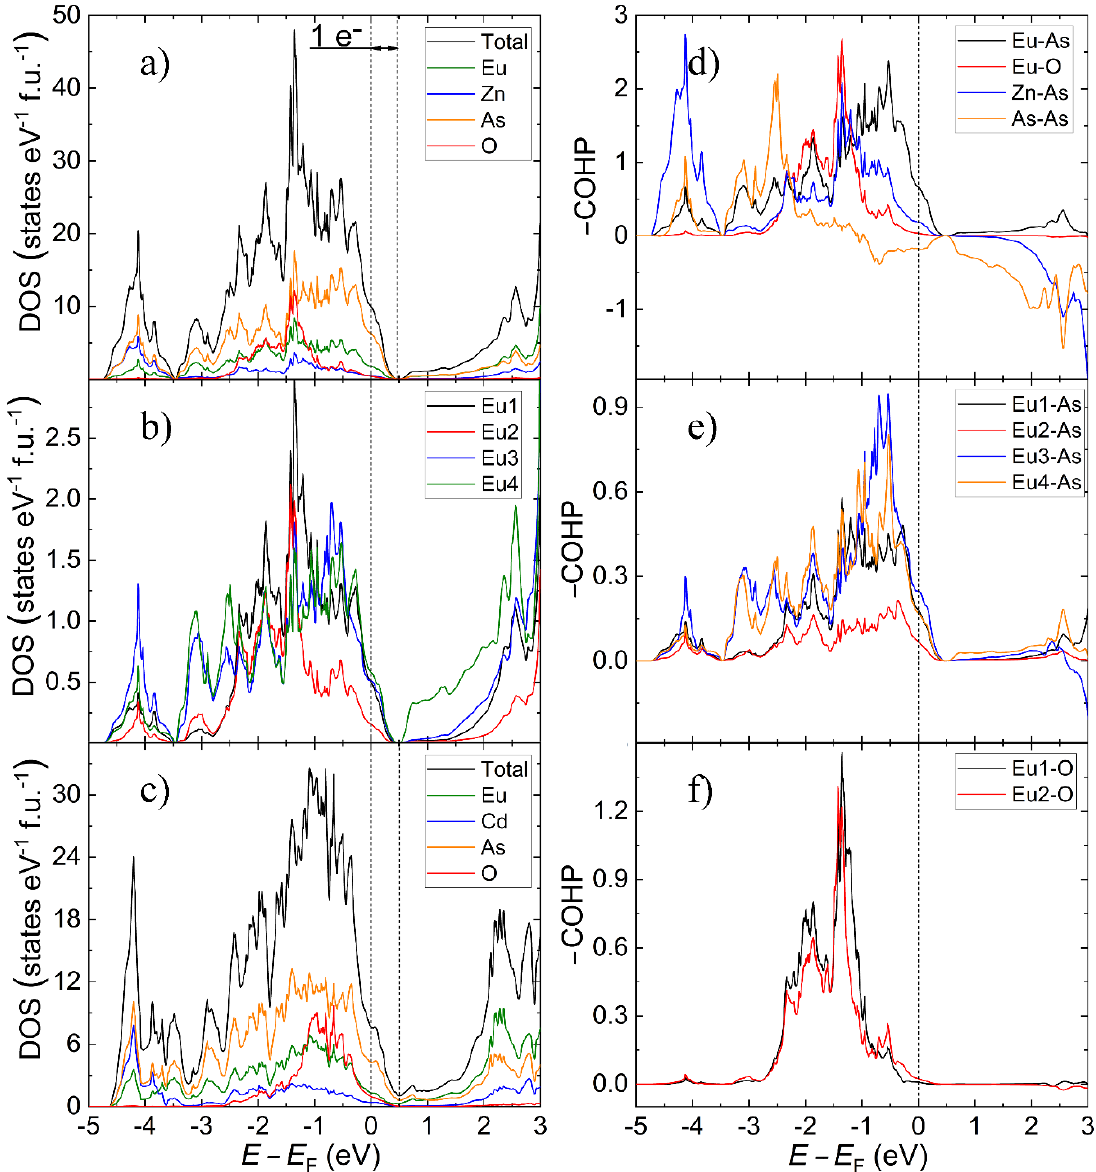
Figure 2. Calculated density of states (DOS) for Eu 5 Zn 2 As 5 O ( a ) and Eu 5 Cd 2 As 5 O ( c ) and partial density of states (PDOS) diagrams ( b ) for Eu atoms in Eu 5 Zn 2 As 5 O. ( a ) Cumulative crystal orbital Hamilton population (COHP) curves ( d–f ) calculated for Eu 5 Zn 2 As 5 O.